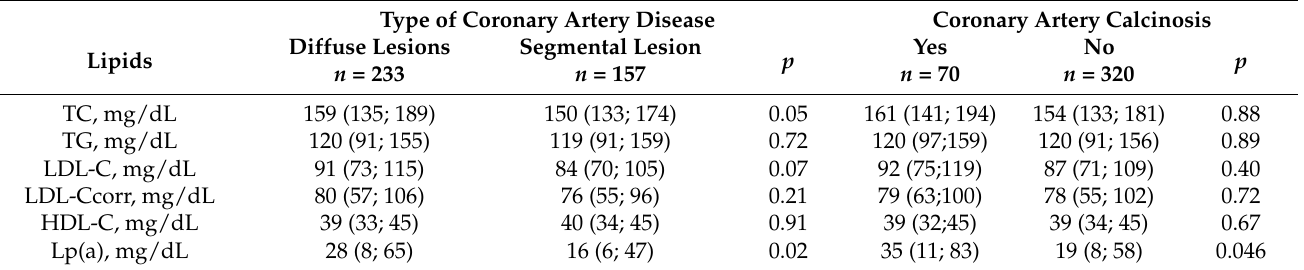
Table 2. Lipids in patients with diffuse and segmental types of coronary artery lesions and with or without CA calcinosis. cholesterol corrected for the concentration of Lp(a), HDL—high-density lipoprotein cholesterol,